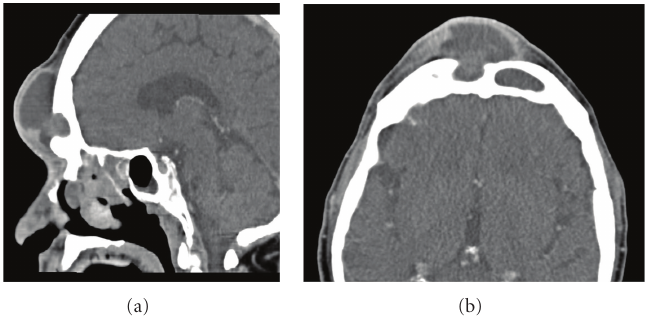
Figure 1: Osteoplastic frontal sinus obliteration (OSFO) in the setting of anterior table erosion. Sagittal (a) and axial (b) CT scan of sixty seven year old man who presented with pansinusitis and right frontal mucopyocele and resulting anterior table erosion. After urgent decompression and six week course of intravenous antibiotics, this patient underwent successful OFSO and has remained symptom-free for eighteen